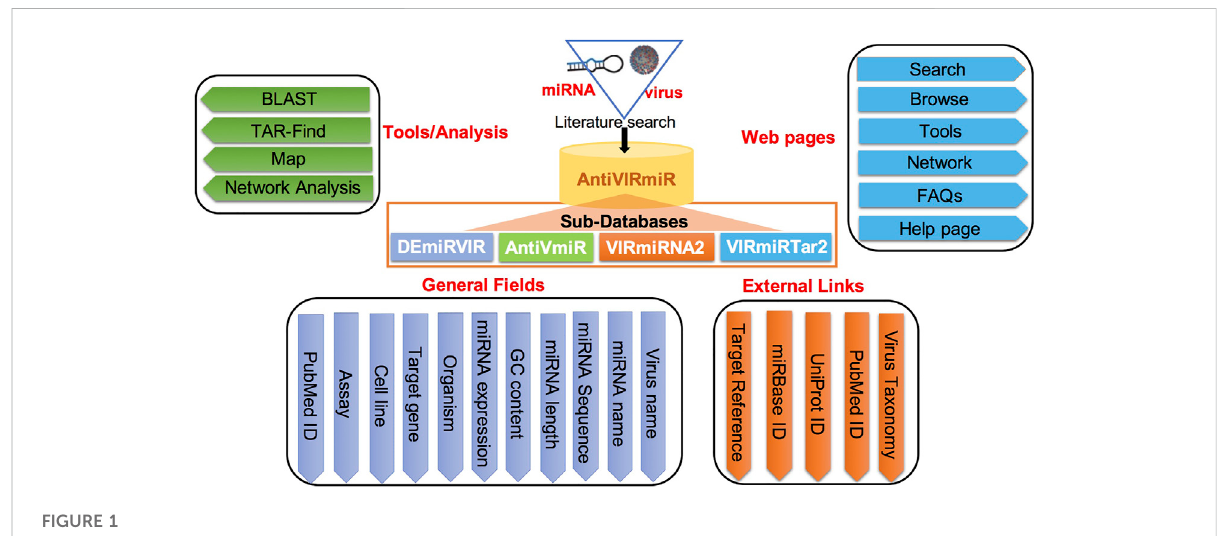
FIGURE 1 AntiVIRmiR